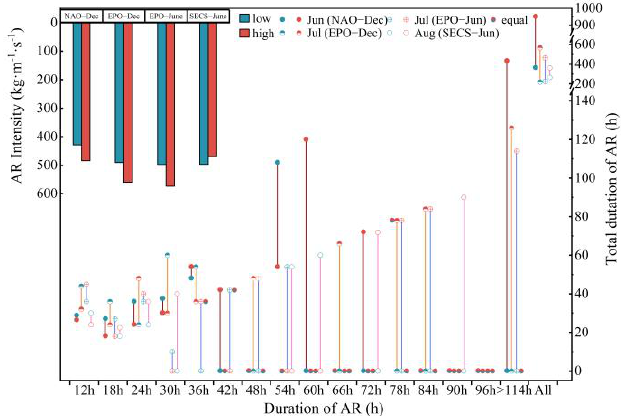
Figure 11. Total duration (unit: h) and intensity (unit: kg·m −1 ·s −1 ) of ARs that passed through the MLYR in the summer in SST anormal years.